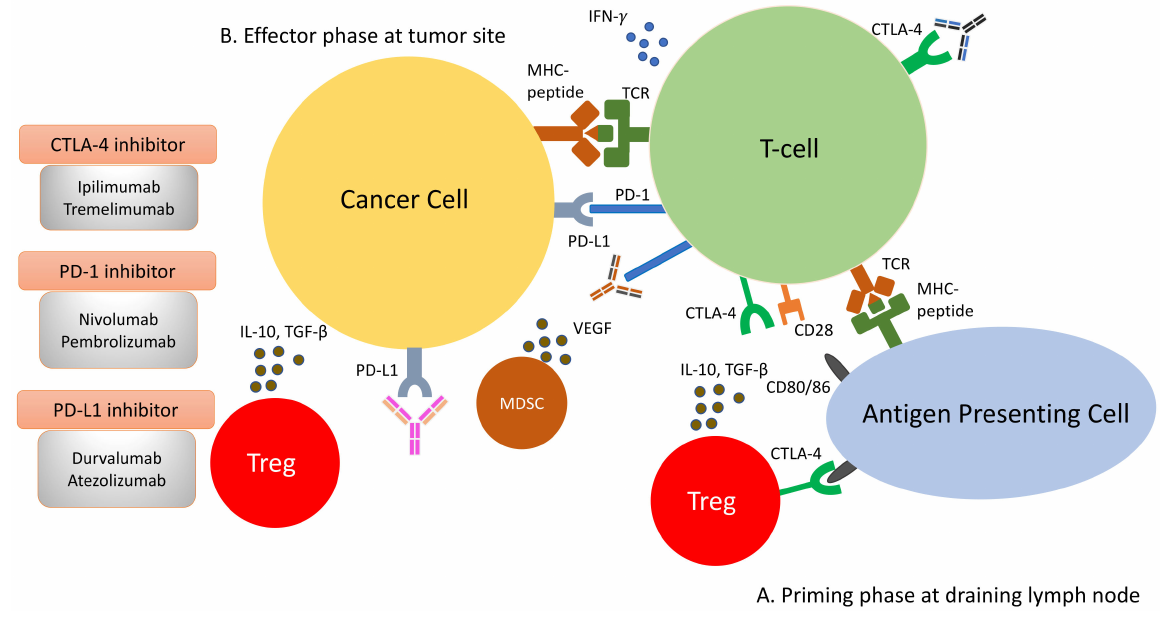
Figure 2. Immune response to tumour cells can be classified into two phases: the priming phase and effector phase ( A ). During priming phase, tumour antigens are detected by antigen-presenting cells, and they circulate back to lymph node to present these antigens to naïve T-cells. Naïve T-cells are activated upon encounter of its cognate antigen. A second signal is required to maintain this